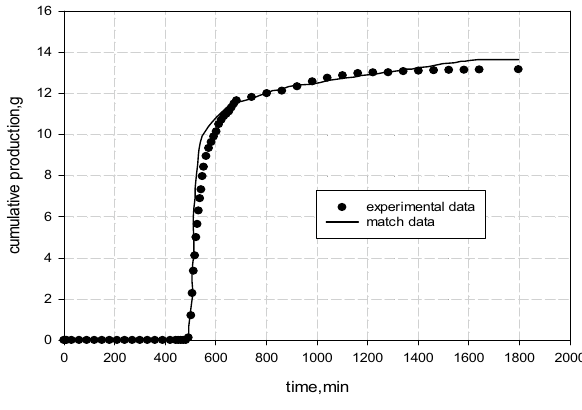
Fig. 5 Cumulative production match curves in CO ment after pressure recovery